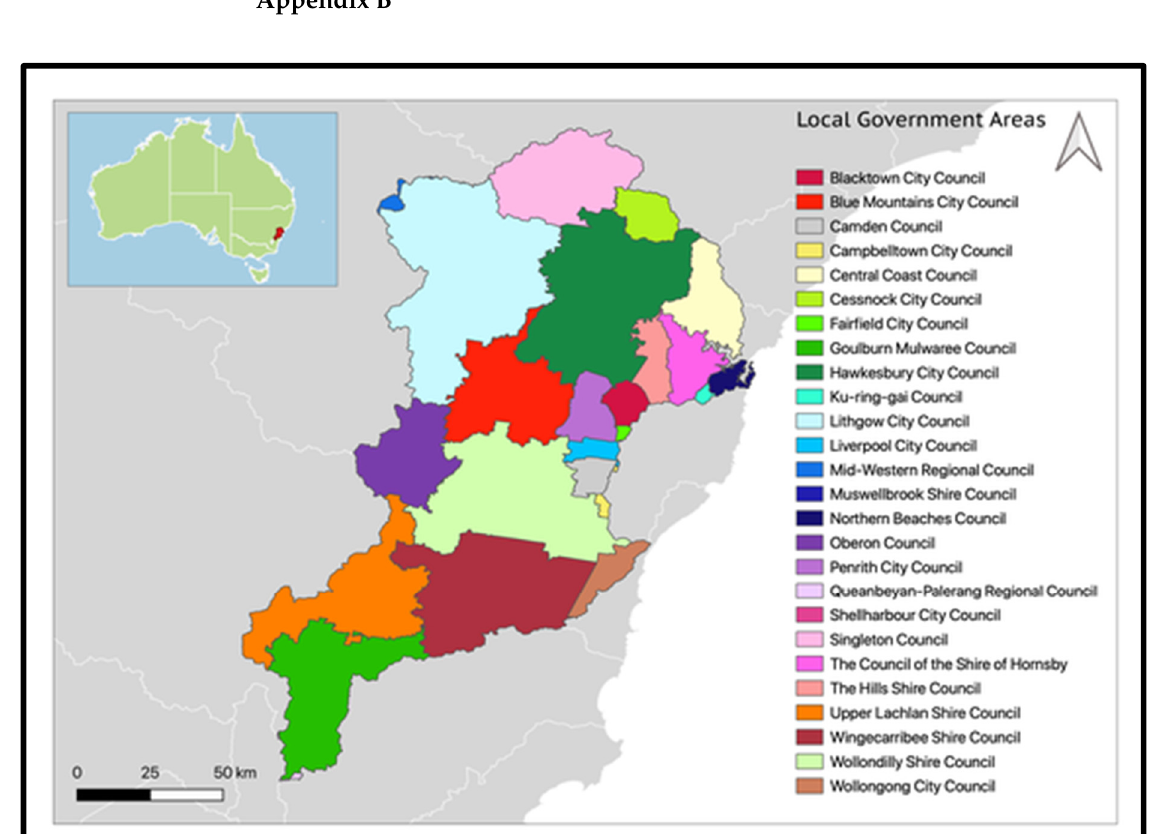
Figure A1. Map of Australia’s Hawkesbury-Nepean Catchment with twenty-six Local Government Areas, as of 2022 (generated using QGIS 3.24 software). Areas, as of 2022 (generated using QGIS 3.24